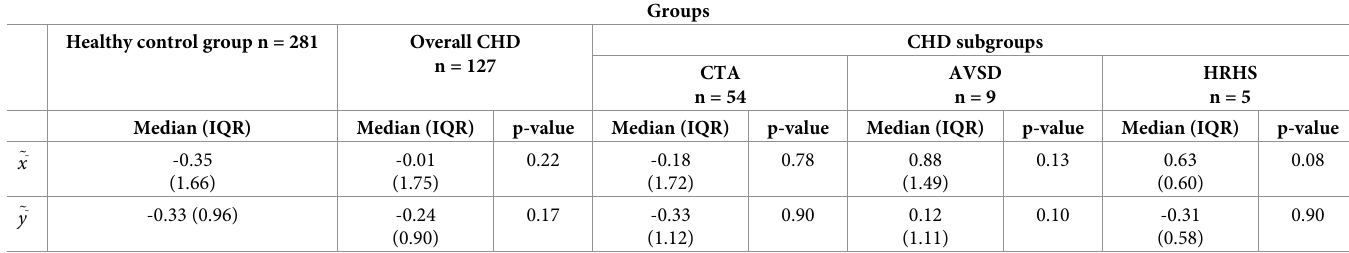
Table 3. Summary statistics (median [IQR]) on the two dimensions for the overall CHD group and each subgroup compared to the healthy control group.